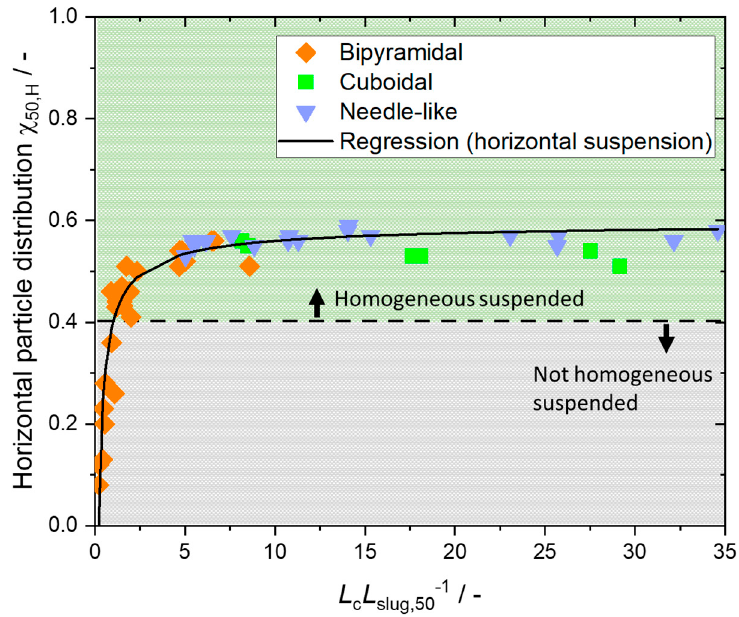
Figure 6. Plot of the horizontal particle distribution represented by χ 50, H over the dimensionless number L c L − 1 . The used data are given in the Supporting Information in Tables S1 and S2.